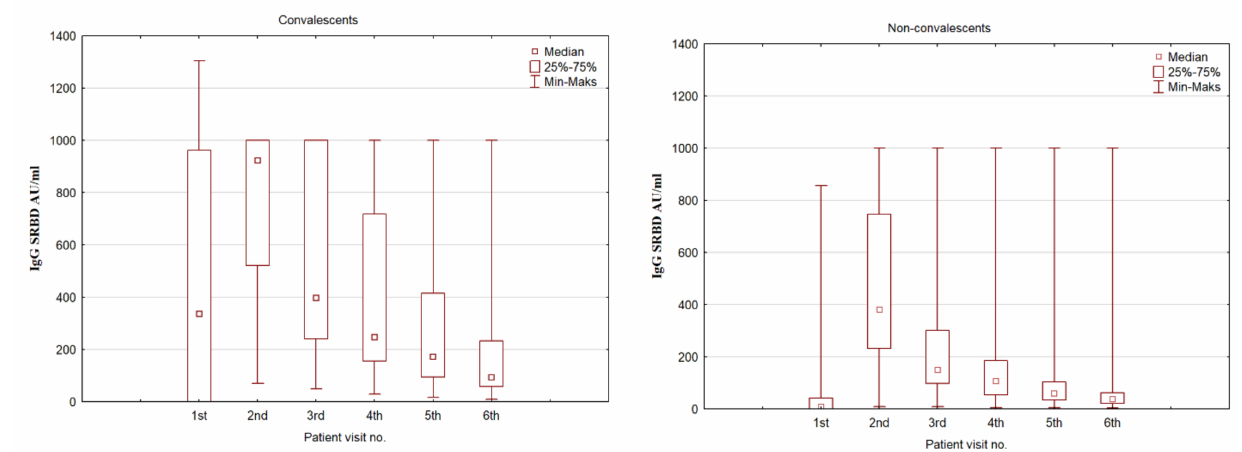
Figure 1. A box plot representing the IgG SRBD serum concentration in COVID-19 convalescents and non-convalescents during the time of the study at predestined time intervals.